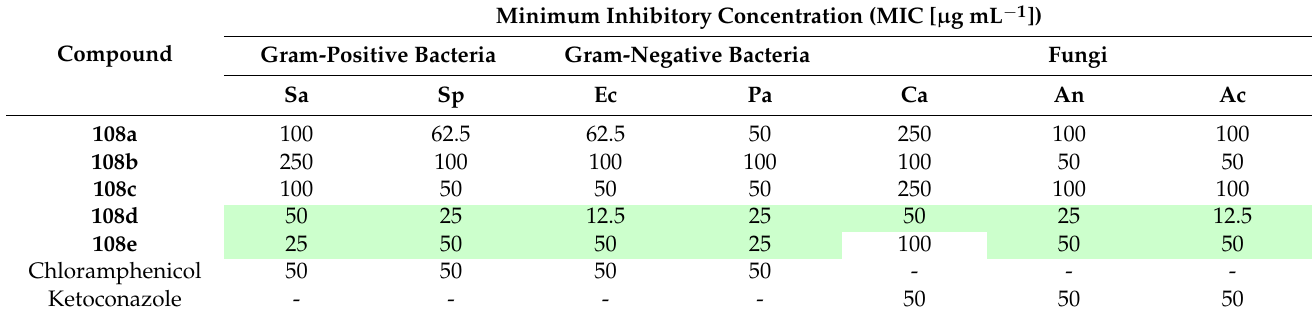
Table 4. In vitro antimicrobial screening results of compounds 108a – 108e.